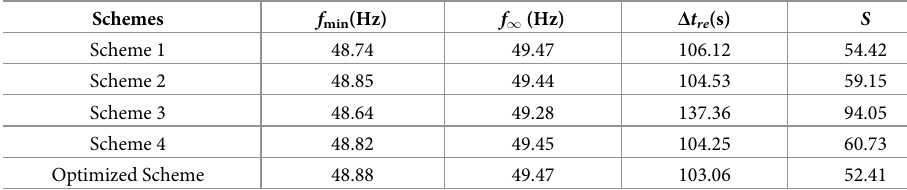
Table 11. Simulation analysis results for different schemes (Case 1).